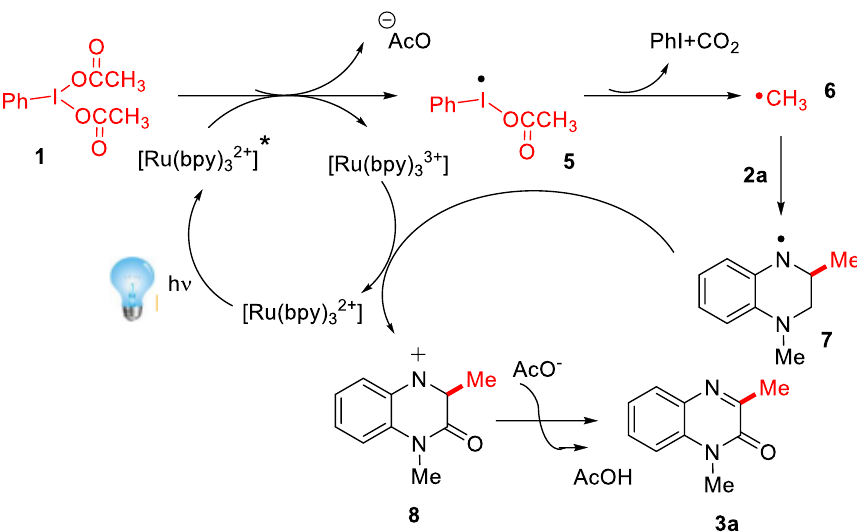
Figure 2. PIDA-mediated radical pathway for the synthesis of 3-alkylquinoxalin-2(1 H )-ones. (b) C-C bond formation reaction on alkenes